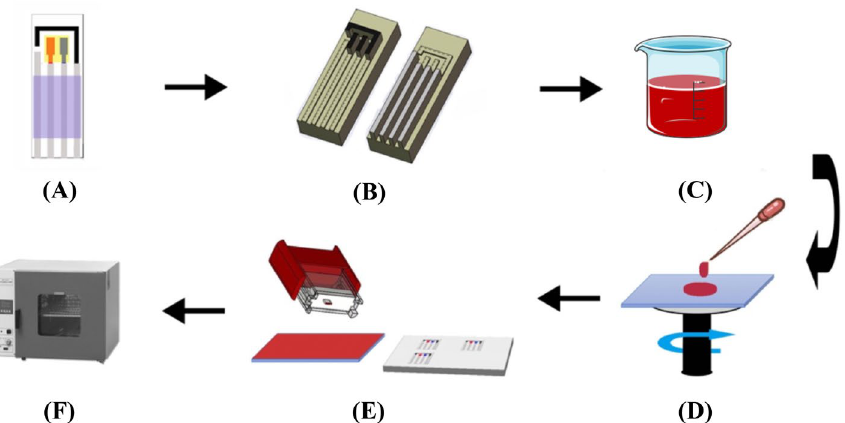
Figure 1. Illustration detailing the steps involved in the movable type bioelectronics printing method including (A) biosensor design, (B) mold design and fabrication, (C) bioelectronic material preparation, (D) spin-coating, (E) transfer printing and (F) post-transfer treatment with an oven for